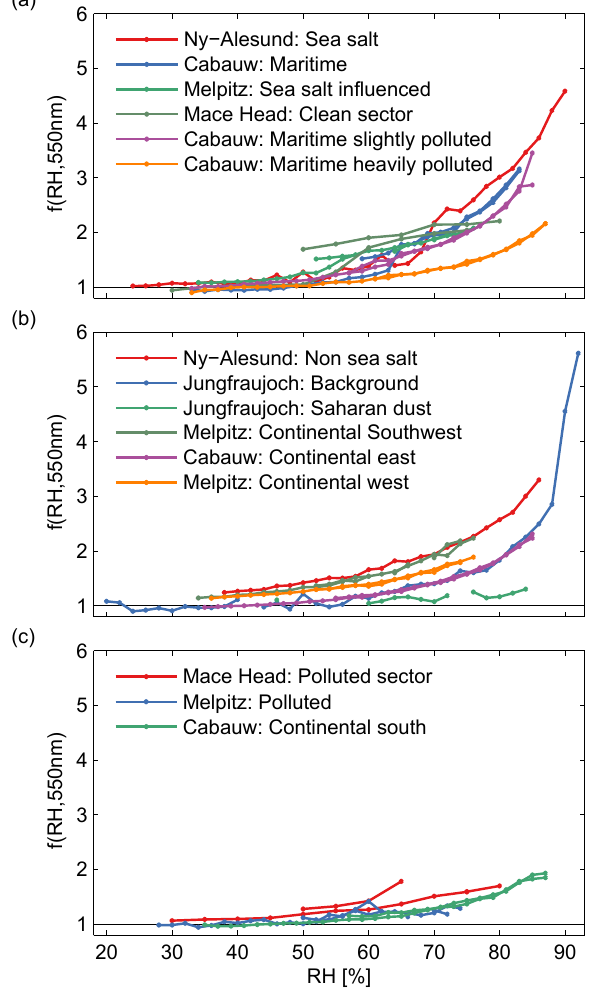
Fig. 5. Example humidograms of f (RH) at λ = 550nm from the different sites with respect to different air masses: (a) maritime, (b) continental and background, and (c) pollution